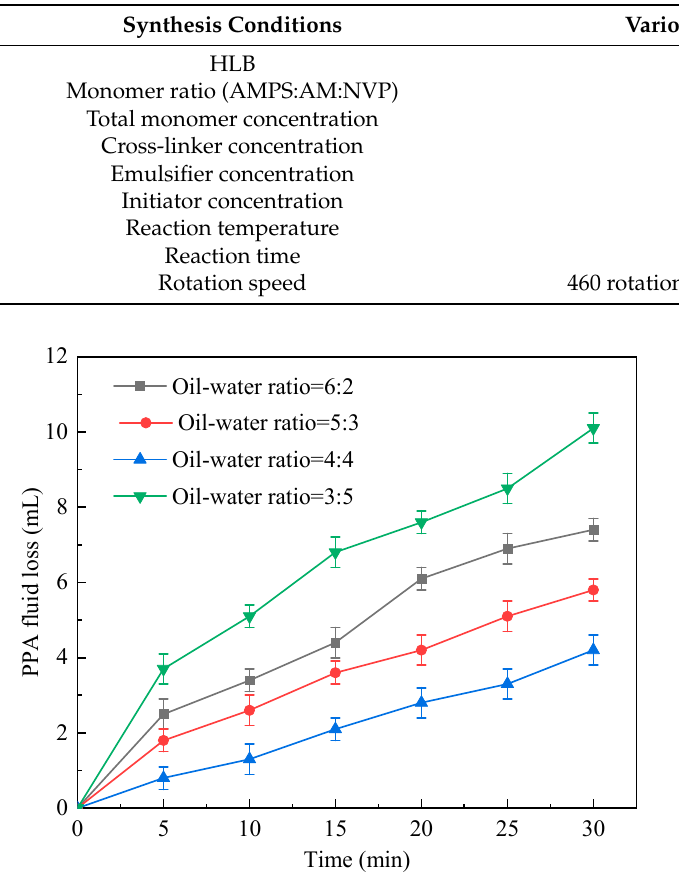
Figure 2. PPA fluid loss vs. time in cases of different oil–water ratios.